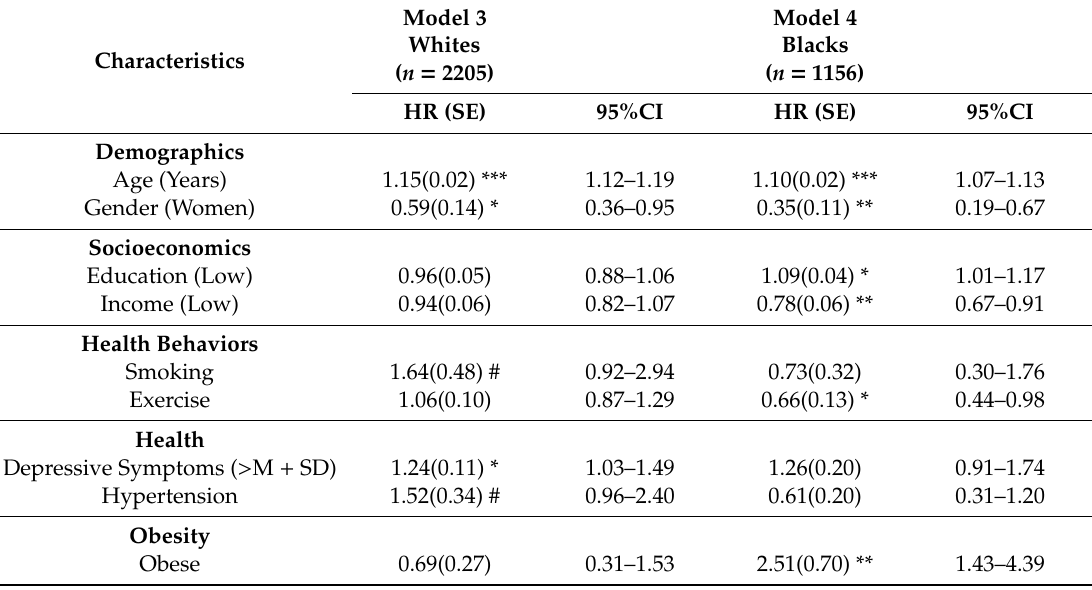
Table 4. Stratified Cox proportional hazards models with time to death due to cerebrovascular disease as the